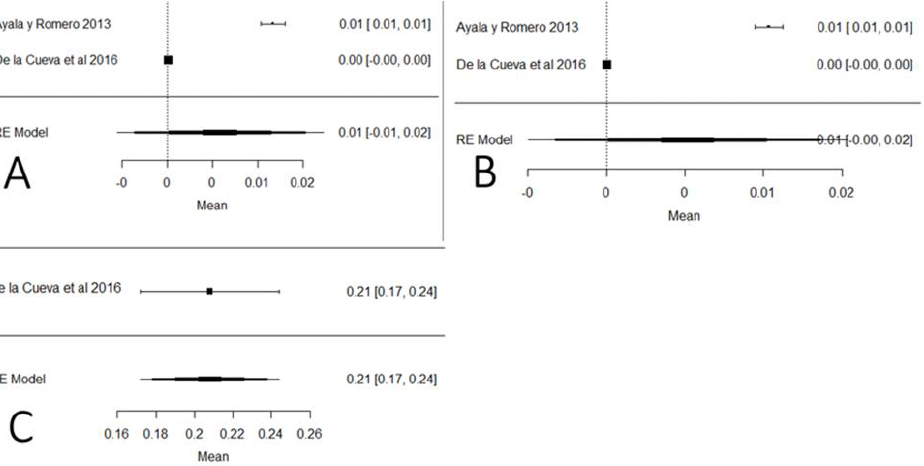
Figure 21. Forest plot for the presence of heavy metals: ( A ) mercury; ( B ) arsenic; ( C ) lead [12,83].